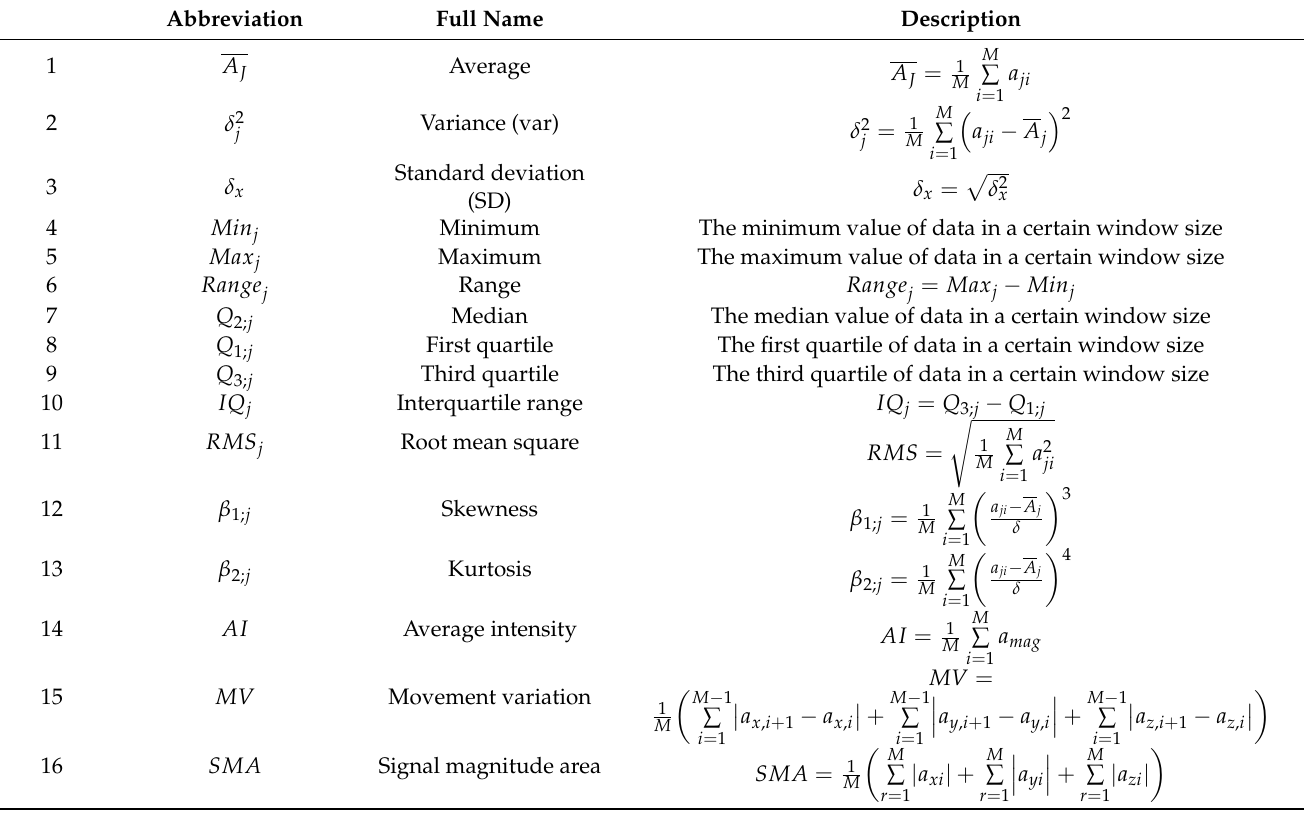
Table 1. Abbreviation and description for each of the calculated features used in this